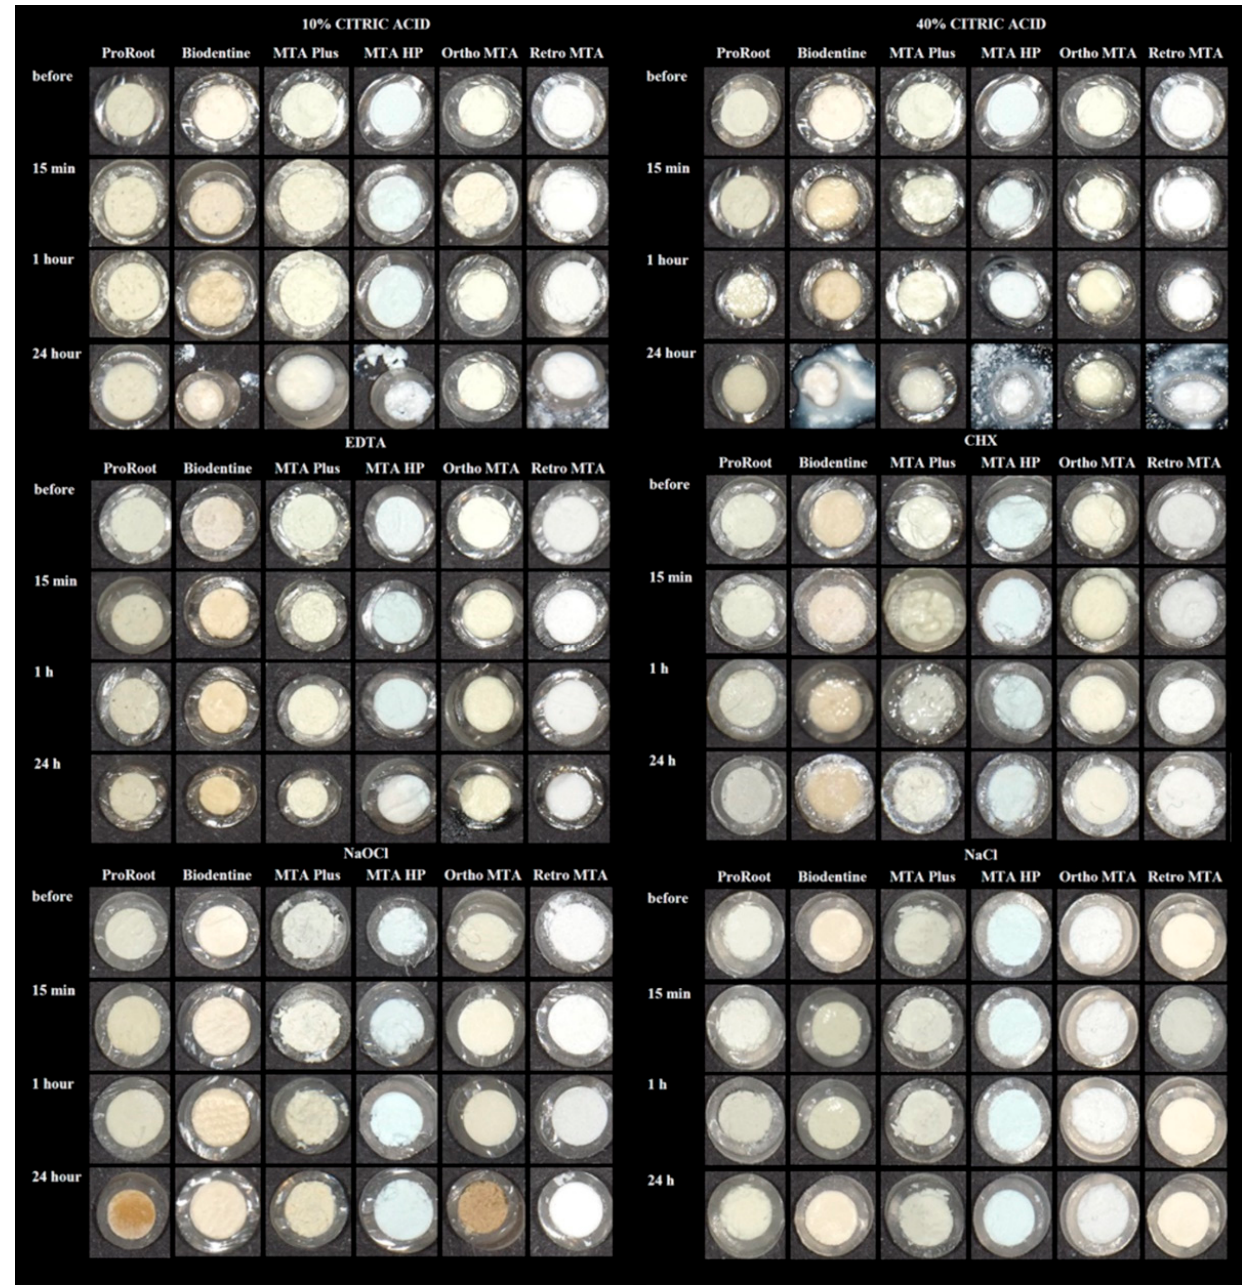
Figure 2. Images of calcium silicate–based cements (CSCs) taken at different time points after setting and immersion in different irrigation solutions.